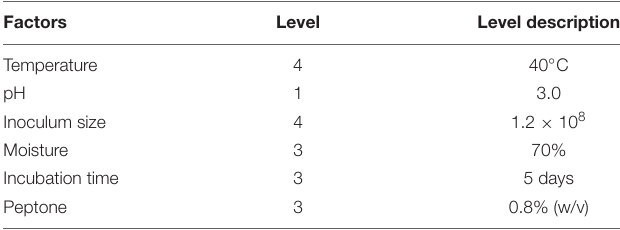
TABLE 5 | Optimized levels of parameters suggested by the statistical design.